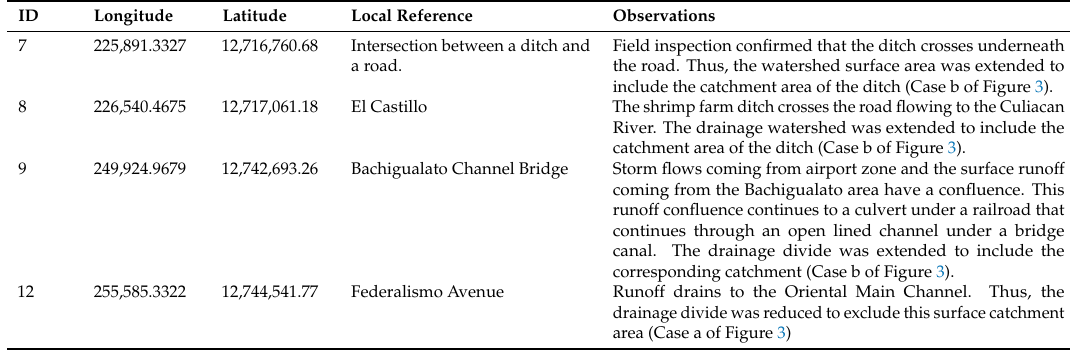
Table 2. Modified sites from the initial